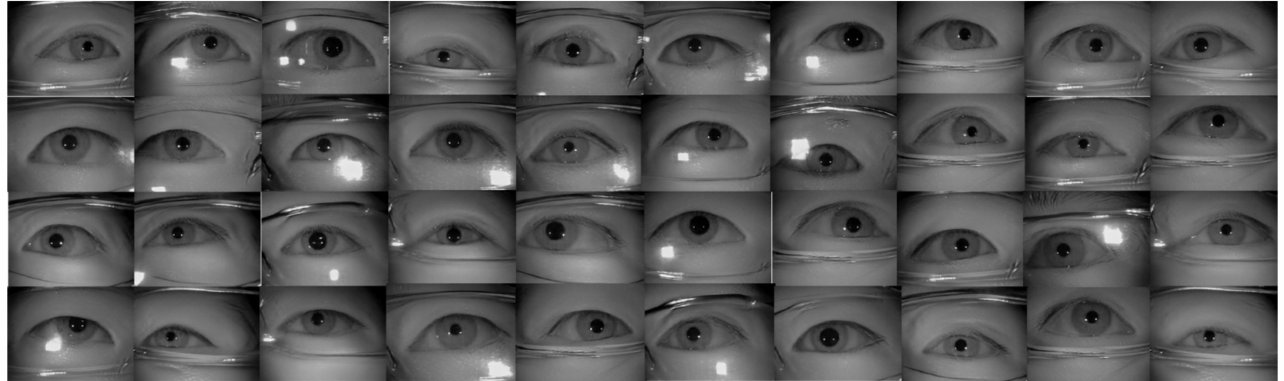
Figure 14. The examples of generated images (trained with CASIA-Iris-Thousands, with glasses) using the proposed iris image generation